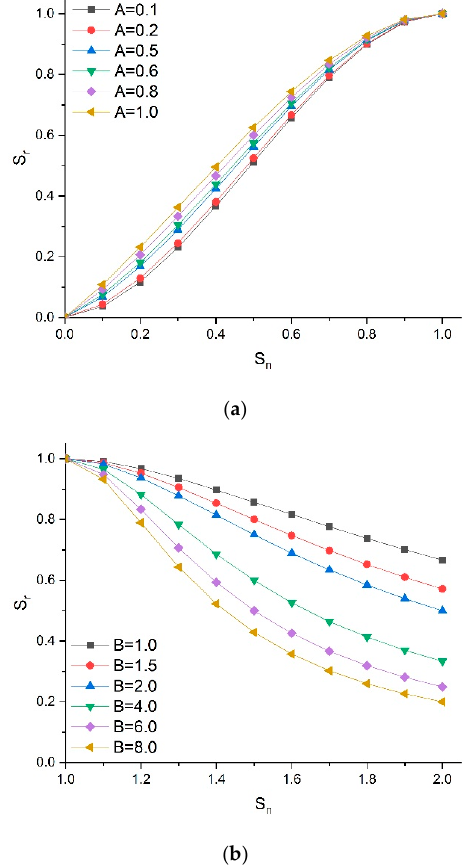
Figure 14. Characteristics of model parameters A and B. ( a ) Influence of parameter A on relative stress-strain relationship, ( b ) Influence of parameter B on relative stress-strain relationship.